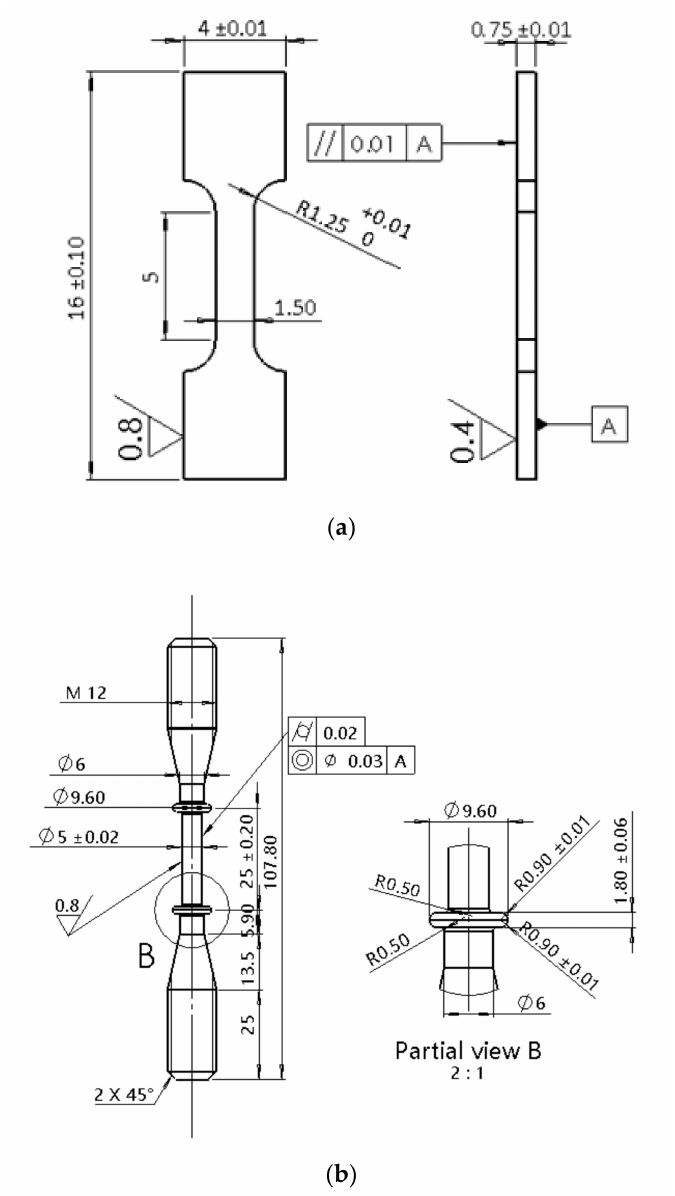
Figure 1. Specimen dimensions: ( a ) miniaturized sheet specimen with a length of 16 mm; ( b ) standard creep specimen with a rod shape and a 108 mm